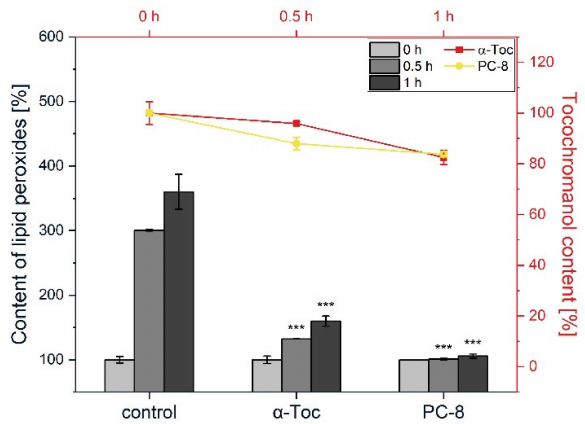
Figure 5. The effect of PC-8 on the rate of the formation of lipid peroxides in plant lipid liposomes initiated by AIPH ( bars ). Time-course of PC-8 decay during the peroxidation reaction ( lines ). The reactions were conducted at 37 ◦ C. The data are means SEM ( n = 3). Asterisks indicate statistically ± significant differences compared with control at corresponding time point (*** p < 0.001; one-way ANOVA followed by Duncan’s post hoc test).